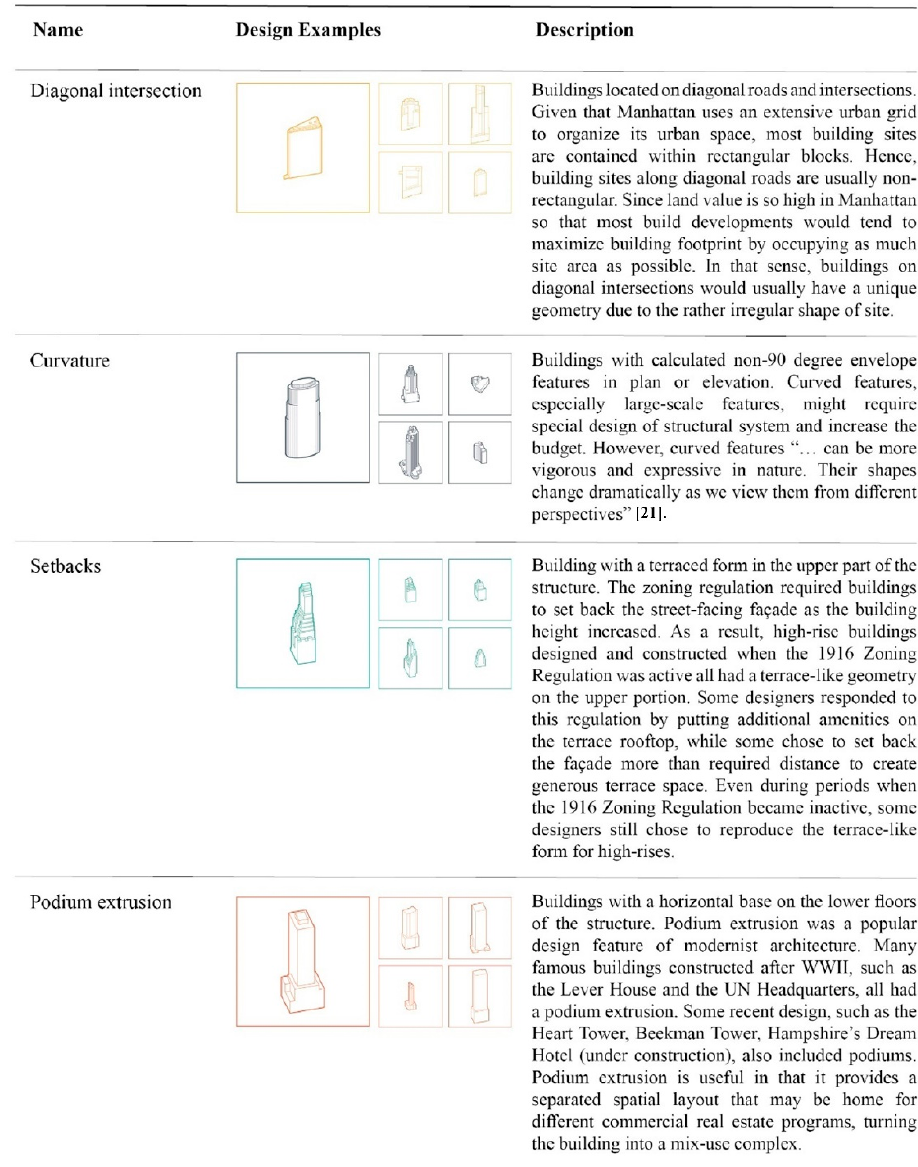
Figure 1. External Architectural Design Features. Figure 1 documents the descriptive elements of four external design features, diagonal intersection, curvature [21], setbacks and podium extrusions as a few external design interventions investigated in this paper. Image: MIT Real Estate Innovation Lab Adaptation, Source: NYC 3D Model by Community District [26].